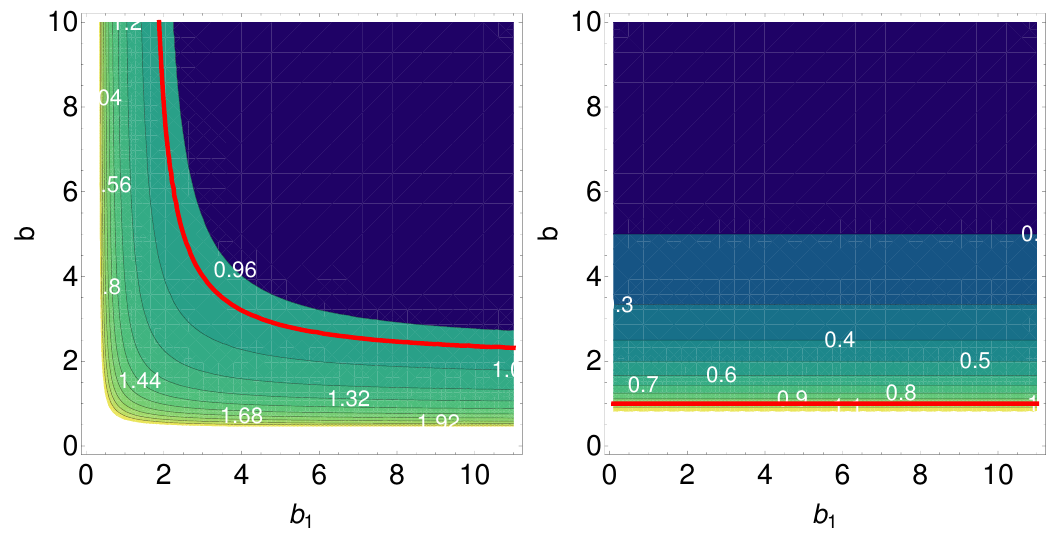
Figure 7 . (Color online) Contour plot showing various causal regions, obtained from eq. (4.70), for fast (left panel) and slow (right panel) branches. The red contour is the critical line of causality, denoting v 2 = 1. The region above the red line is causal for the slow magneto-sonic waves and L acausal below similarly for the fast magneto-sonic wave right side of red line is causal region and left side is acausal region. The magnitude of the magnetic (cid:12)eld has been (cid:12)xed to qB = 10 m 2 the other parameters used are (cid:11) = 1 = 3, T = 200